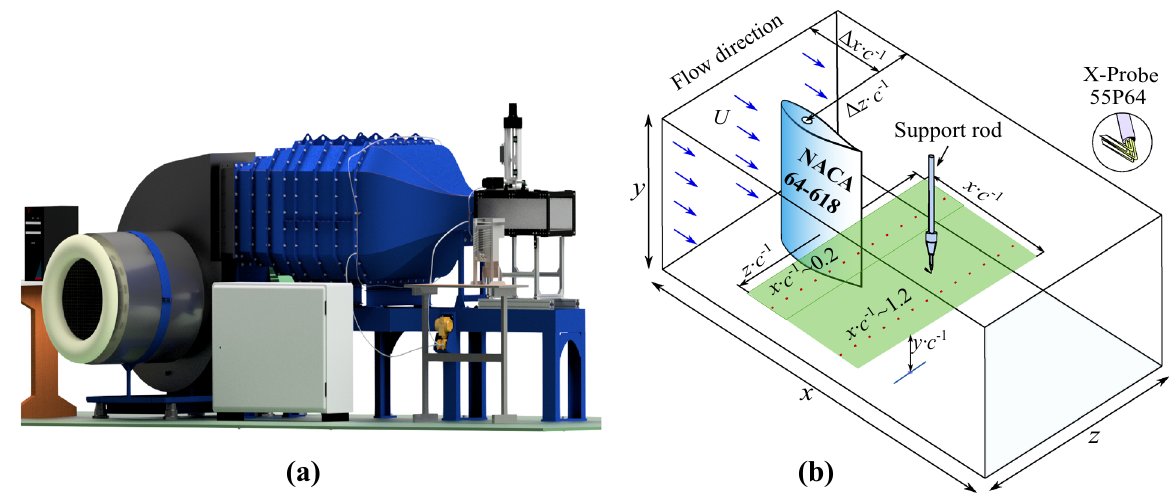
Fig. 1 a Principle construction of the wind tunnel. b Airfoil testing schematic diagram. Where z ⋅ c − 1 and x ⋅ c − 1 respectively sizes of the measuring field. Blue arrows indicate the airflow